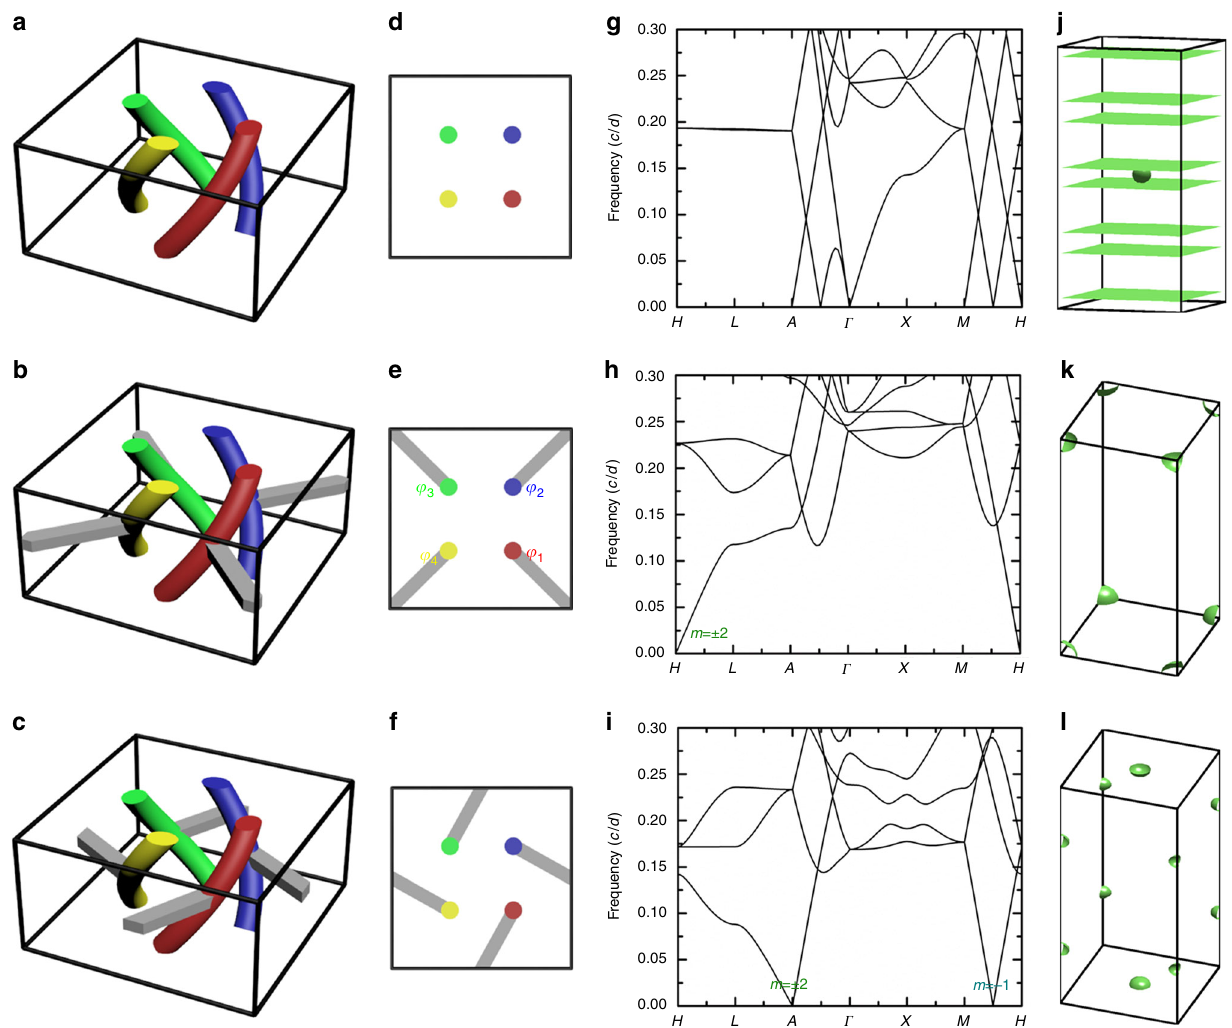
Fig. 4 Shifting of the zero-frequency modes in the k x and k y directions through the introduction of in-plane connection. a Square array of isolated wire bundles. b Wire bundles (colored) with in-plane connecting bars (gray) that pass through the unit cell corner. c Wire bundles with in-plane connecting bars that pass through the unit cell boundary. d – f Corresponding cross-sectional views. g – i Band structures. j – l Equifrequency surfaces at 0.04 c / d showing index ellipsoids or planes at different k -points. The in-plane connection in b shifts the zero-frequency mode with m = ± 2 to ( k x , k y ) = ( π / a , π / a ), whereas the connection in c maintains the m = ± 2 mode at ( k x , k y ) = (0, 0) but shifts the m = ± 1 modes to ( k x , k y ) = ( π / a , π / a